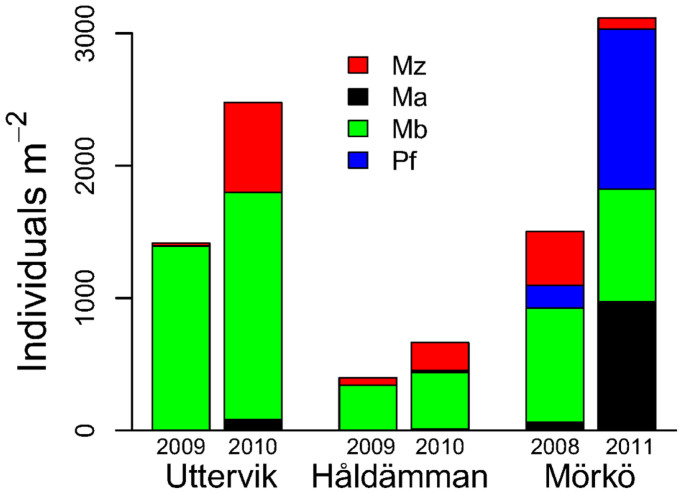
Species composition and abundance of benthic deposit-feeders at the sampling stations in 2009 and 2010 or 2008 and 2011.Ma = Monoporeia affinis, Mz = Marenzelleria arctia, Mb = Macoma balthica and Pf = Pontoporeia femorata. Samples at stn Mörkö were collected in October resulting in two year classes of amphipods being present, whereas only one year class was found at the other stations, which are sampled in May.